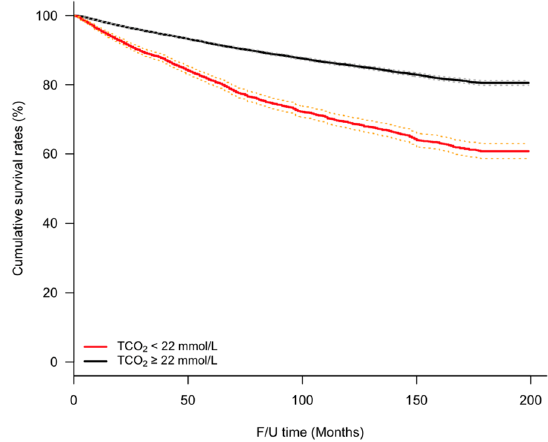
Figure 2. Survival analysis for all-cause mortality in the study cohort. Crude mortality rate was 12.2% during the median 77.0 months of follow-up, and Kaplan–Meier curve showed that Low TCO 2 group had higher mortality, compared to normal TCO 2